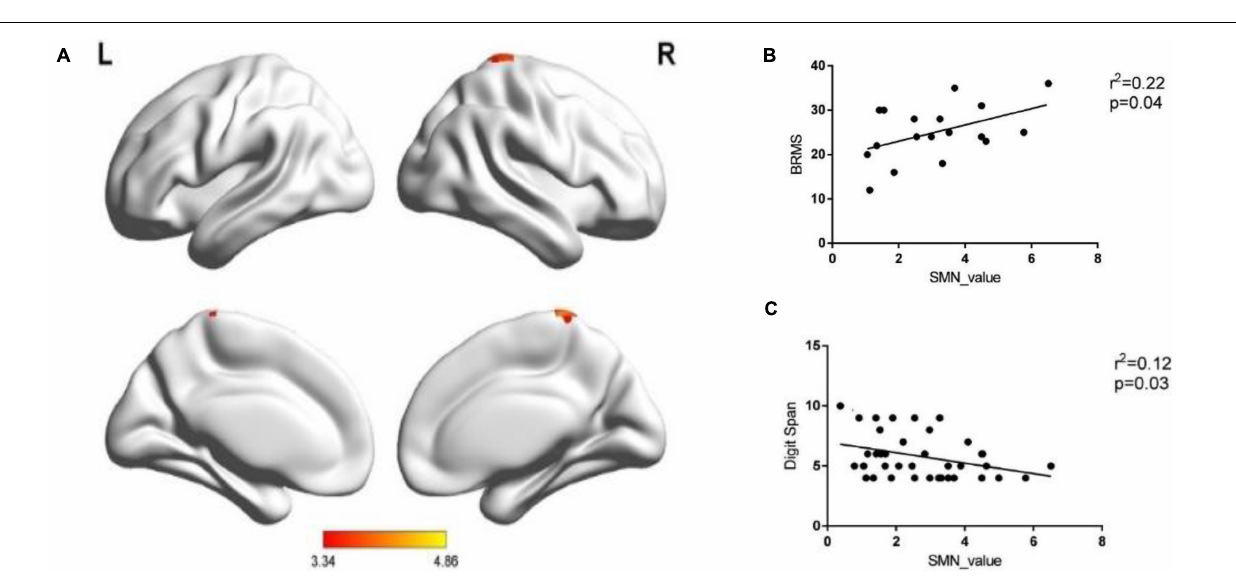
FIGURE 2 | The within-network connectivity of SMN. (A) Patients BD-I showed increased within-network connectivity in the right paracentral lobule and the right postcentral gyrus in the SMN compared with HCs. (B) The correlation between the within-network connectivity value of SMN in patients and the BRMS score. (C) The correlation between the within-network connectivity value of SMN in all subjects and digit span forward